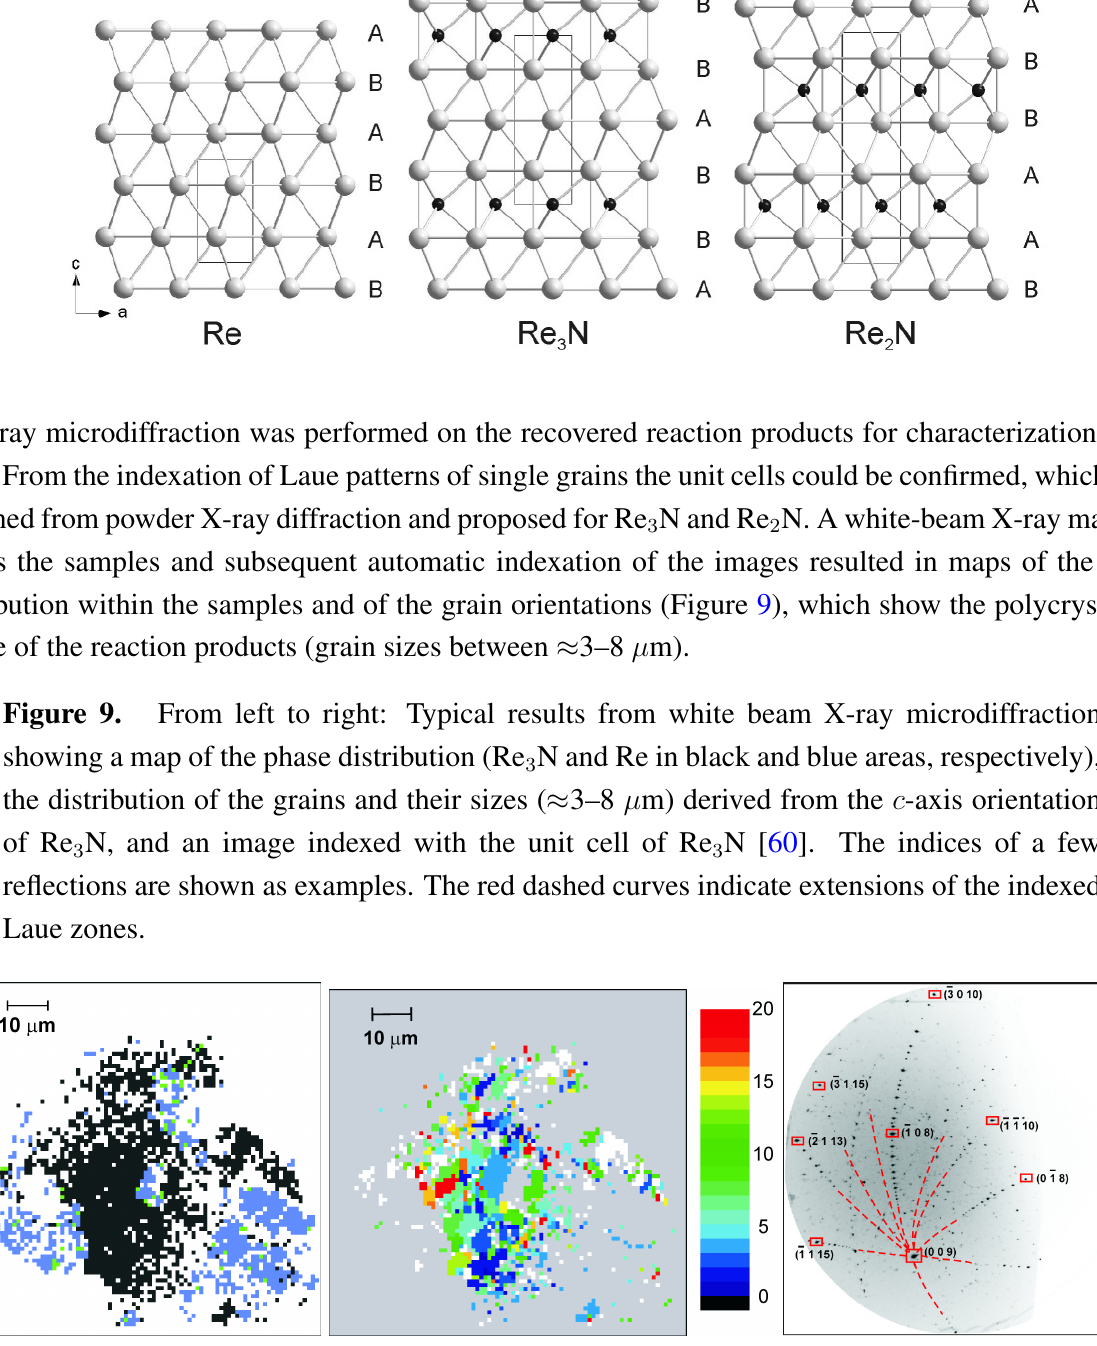
Figure 8. Comparison between the crystal structures of Re, Re